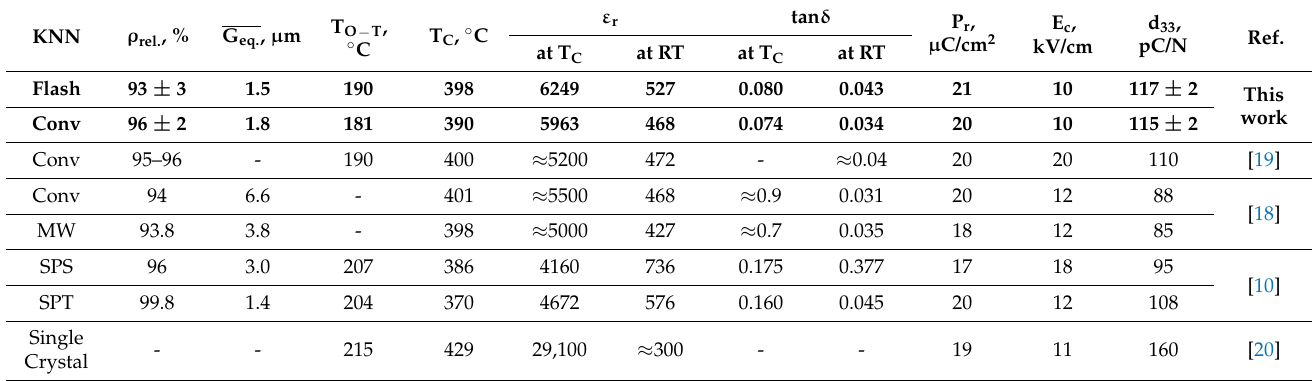
Table 1. Relative density ( ρ rel. ), average equivalent grain size (G eq. ), orthorhombic to tetragonal (T O − T ), and tetragonal to cubic (T C ) transition temperatures, relative dielectric permittivity ( ε r ) and dissipation factor (tan δ ) at T C and room temperature (RT), as well as RT remnant polarization (P r ), coercive field (E c ) and piezoelectric coefficient (d 33 ) of Flash and Conv KNN ceramics of this work in comparison with literature